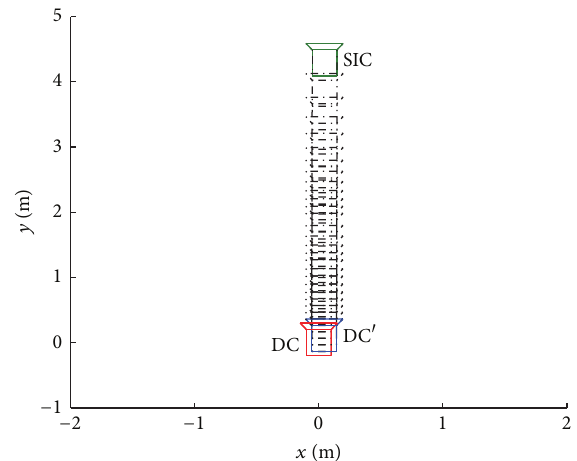
Figure 10: The third step: the robot trajectory. DC is the desired configuration, DC 󸀠 is the final configuration, and SIC is the inter- mediate configuration of the second step. In this step, the robot is moving from SIC to DC 󸀠 .